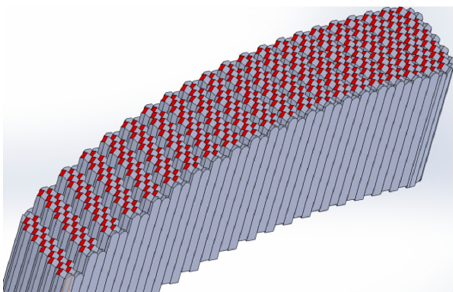
Figure 16. Double-pin group.